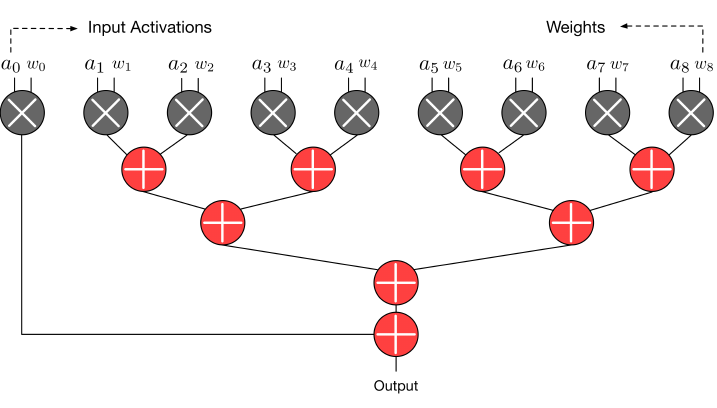
Figure 2. Operations of a 3 × 3 convolver.